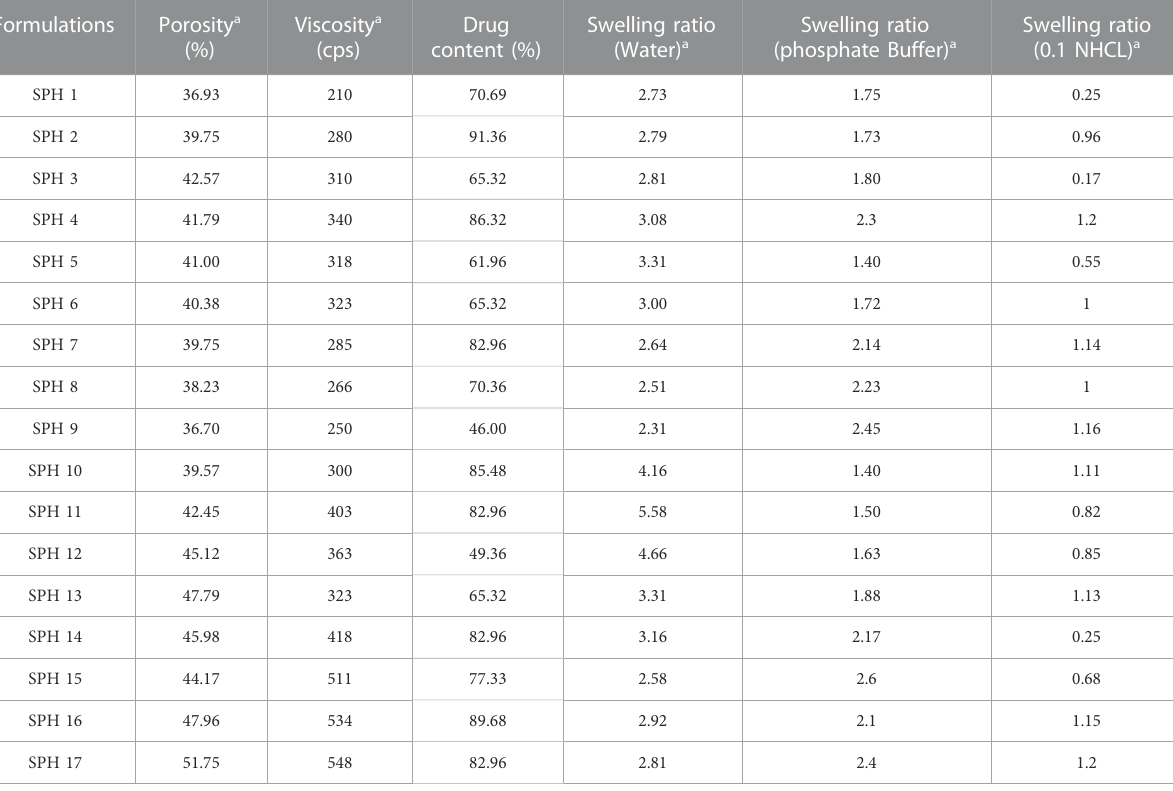
a Average of three